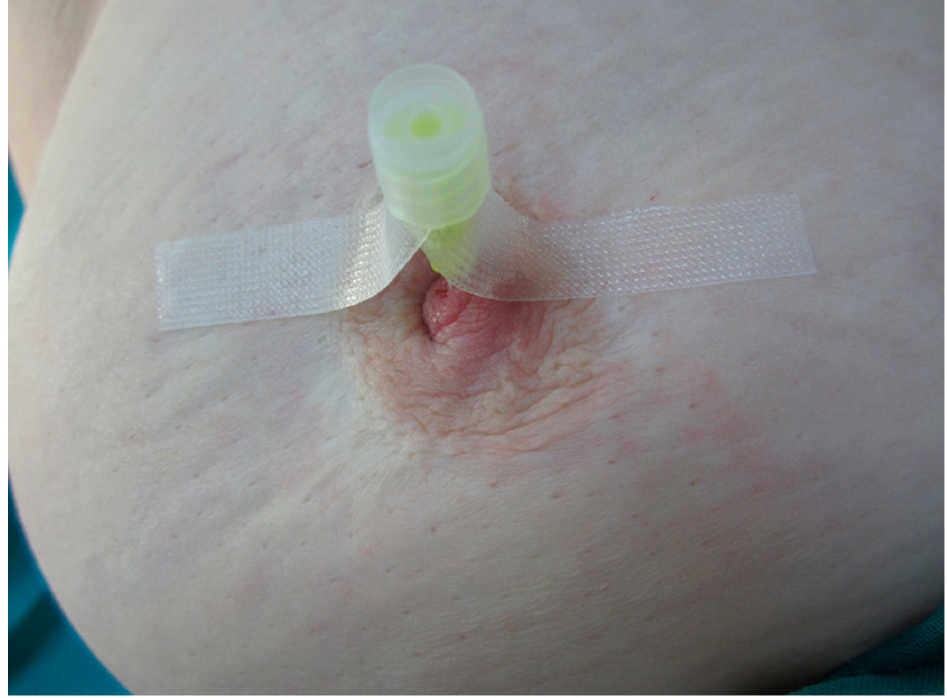
Figure 2. Catheter with cap and fixed with